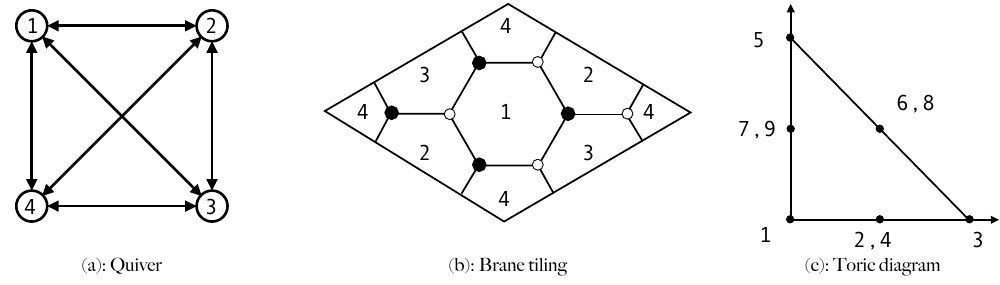
Figure 7 . Quiver, tiling and toric diagram of the 4d parent of the 3d model studied in section 4.1. they correspond to all the sets of edges in which each node is incident to exactly one